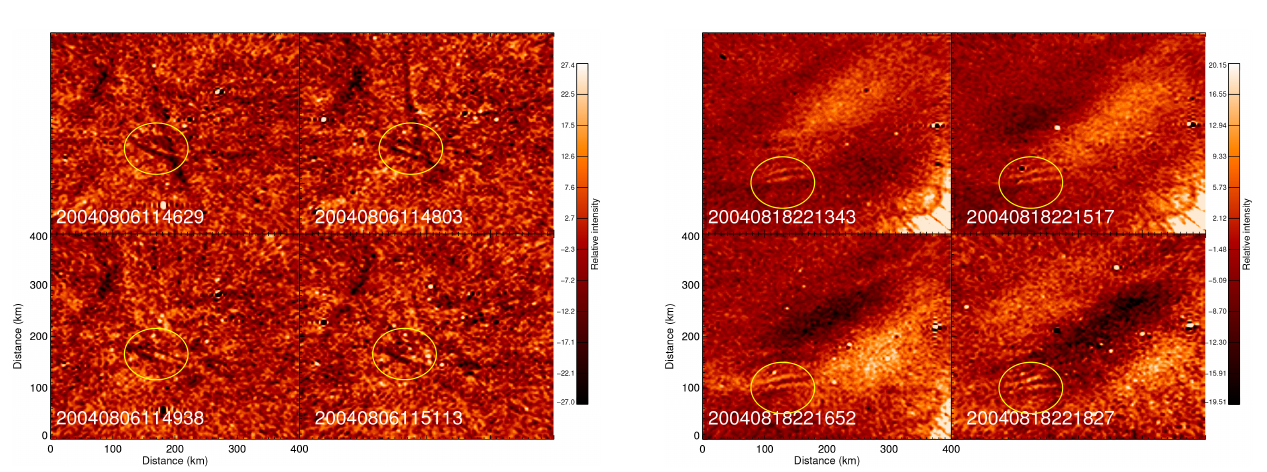
Figure 1. Processed Na image from 6 August 2004. The images were unwarped onto a 400 × 400km geographic grid (shown in the bottom left image) with the positive y axis corresponding to 0 ◦ lon- gitude. Yellow circles mark the location of the observed wave in each image. Time stamps are shown in the bottom left of each im- age, and are read as YYYYMMDDHHMMSS. The sequence of im- ages starts at the top left, and follows to the top right, bottom left, and finally bottom right.